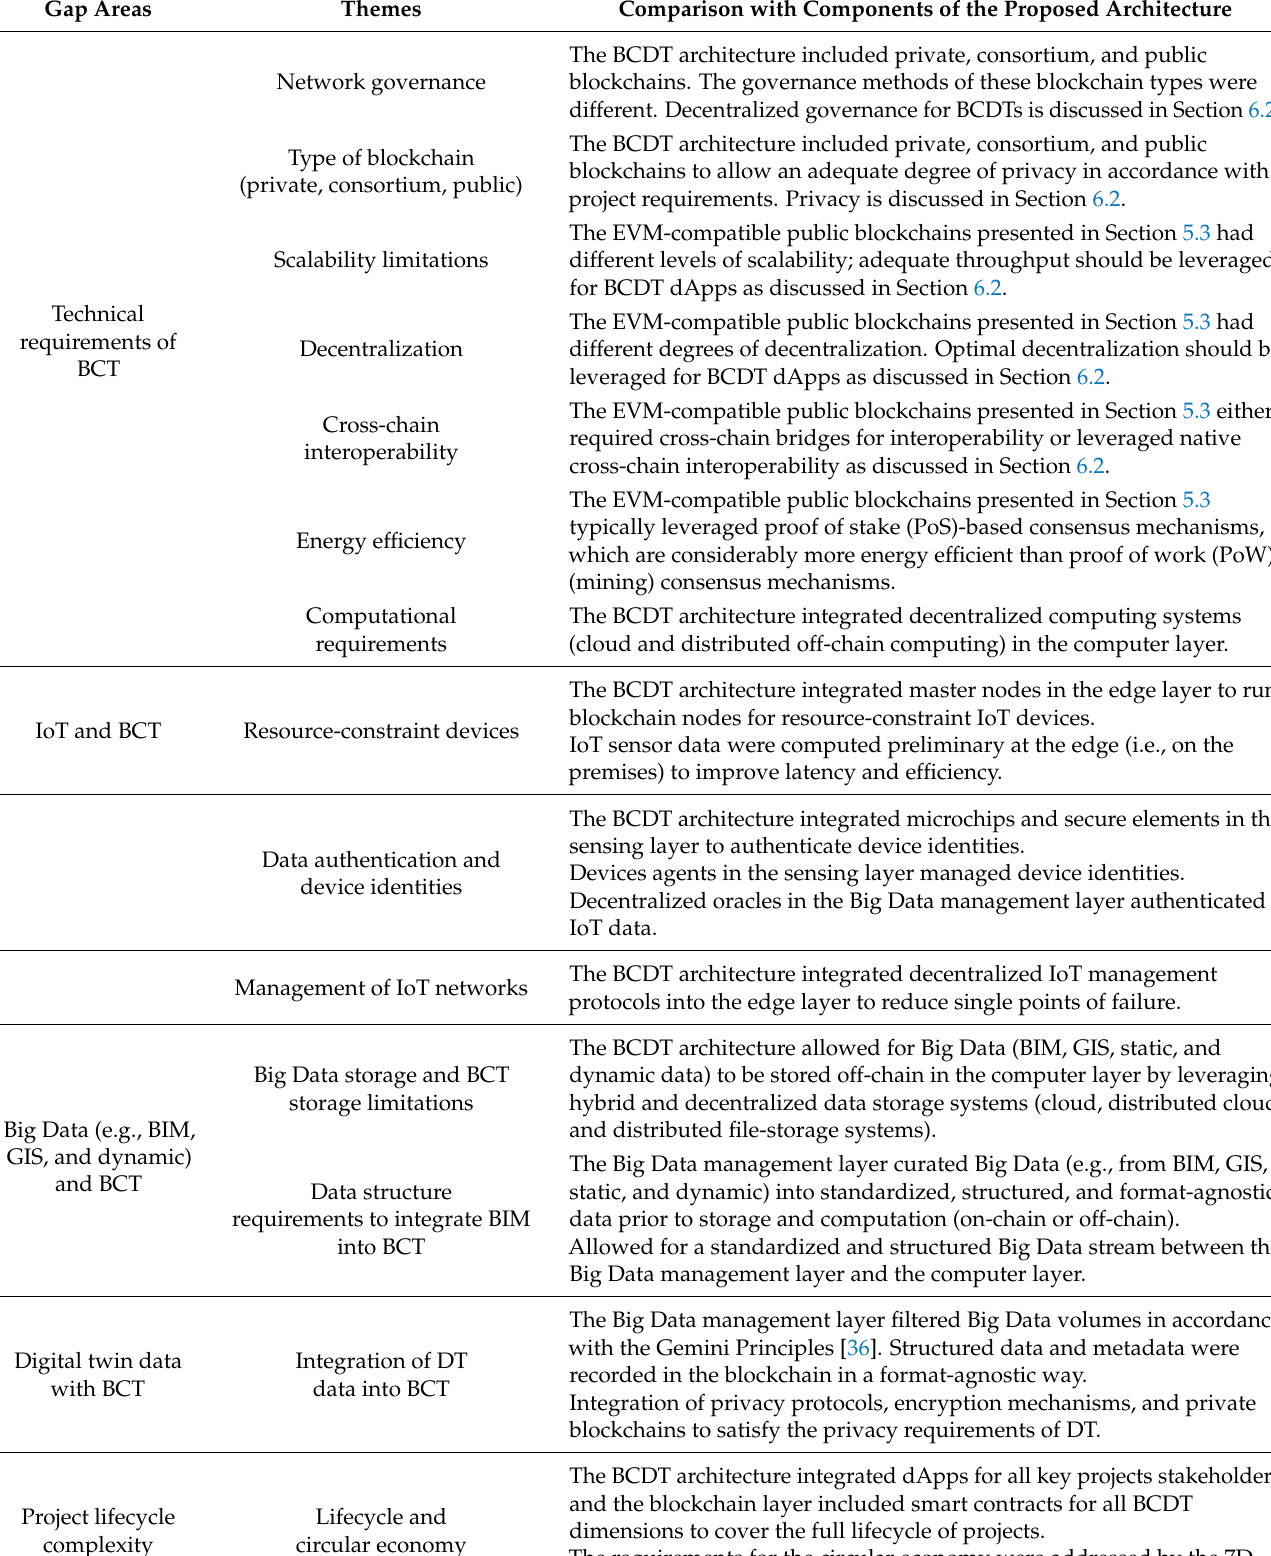
Table 5. Evaluation of the proposed architecture against the technical